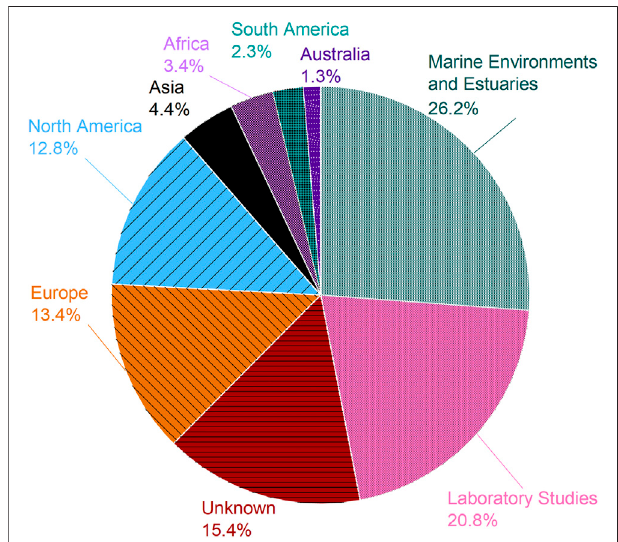
FIGURE 3 | (A) Proportion of microplastic publications found in Web of Science between 2013 and 2021 that have a dataset in an open access repository; (B) Number of data sets in open access repositories during the same period along with the annual number of peer-reviewed microplastics articles published.